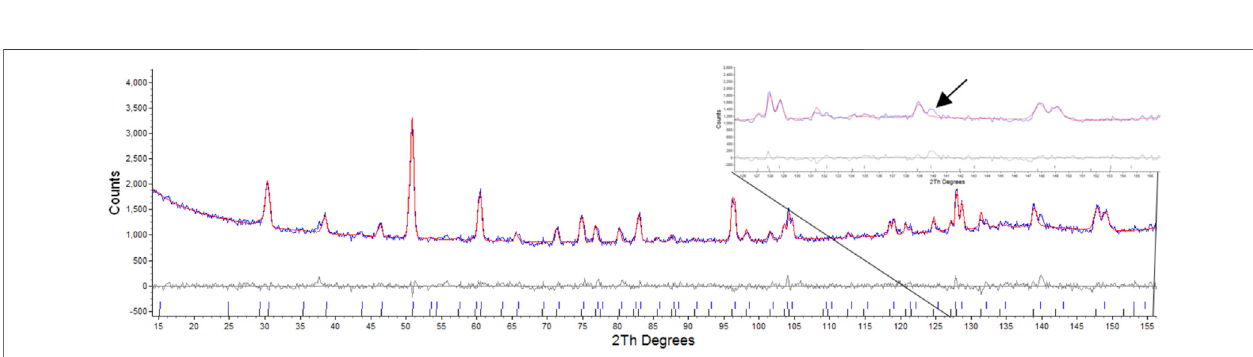
FIGURE 3 | Rietveld re fi nement of radiation damaged Nd 2 Zr 2 O 7 showing difference plot and assignment of defect fl uorite and pyrochlore, insert highlights the absence of the equivalent re fl ections for the (10 6 4) and (12 2 2) that result only due to scattering from Oxygens as per Heremans et al.